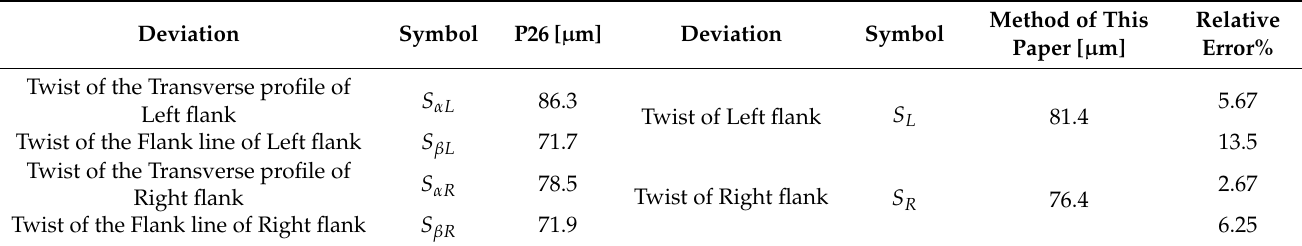
Table 4. Comparison of P26 results with the experimental results of this